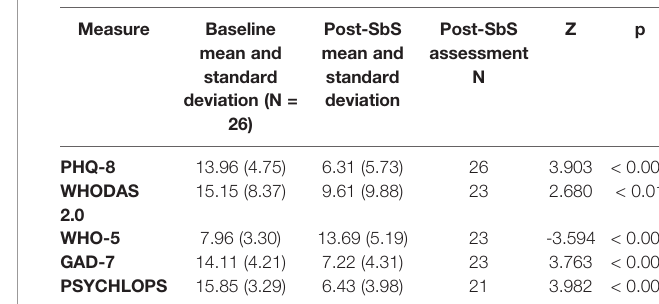
TABLE 2 | Mean scores, standard deviations and results of Wilcoxon signed ranks test for all outcome measures among participants who completed post- SbS assessment.